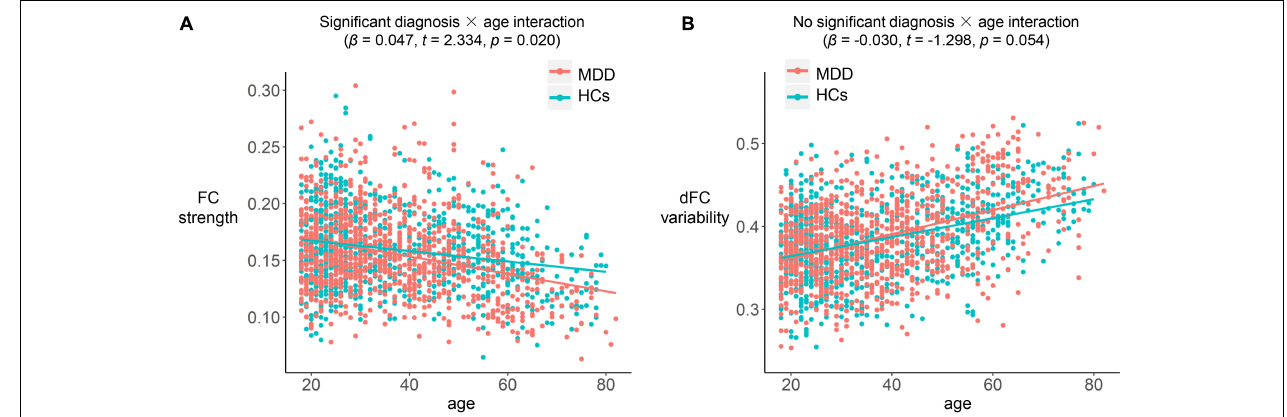
FIGURE 3 | Associations between age and DMN FC strength (A) /dFC variability (B) in each group.